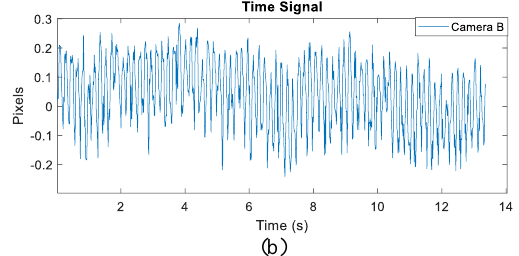
Figure 8. Vibration measurement results using videos acquired